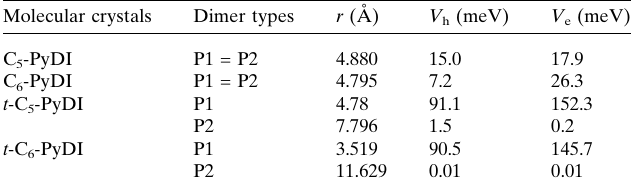
Table 2 Calculated electronic coupling terms V h (hole transfer) and V e (electron transfer) for the different hopping pathways in C 5 -PyDI, C 6 -PyDI, t -C 5 - PyDI and t -C 6 -PyDI crystals; r is the intermolecular center-to-center